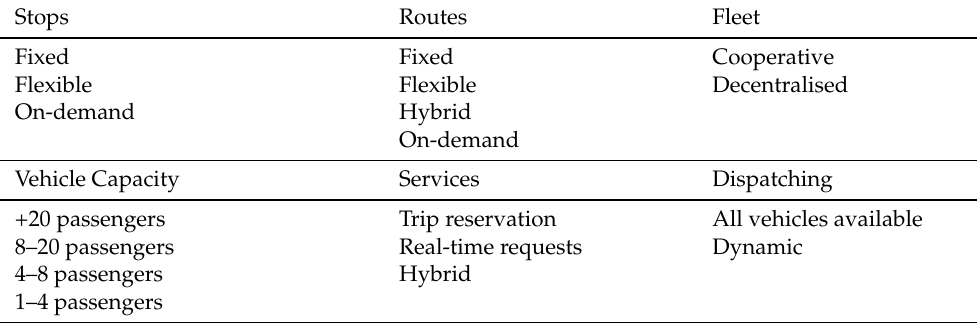
Table 1. Review of Demand-responsive transportation system configurations. Column headers identify common elements to all systems. Rows enumerate configuration options of their corresponding element. Read from top to bottom, the options transition from a non-flexible shareable system to a flexible but less shareable system. Stops Routes Fleet Fixed Cooperative